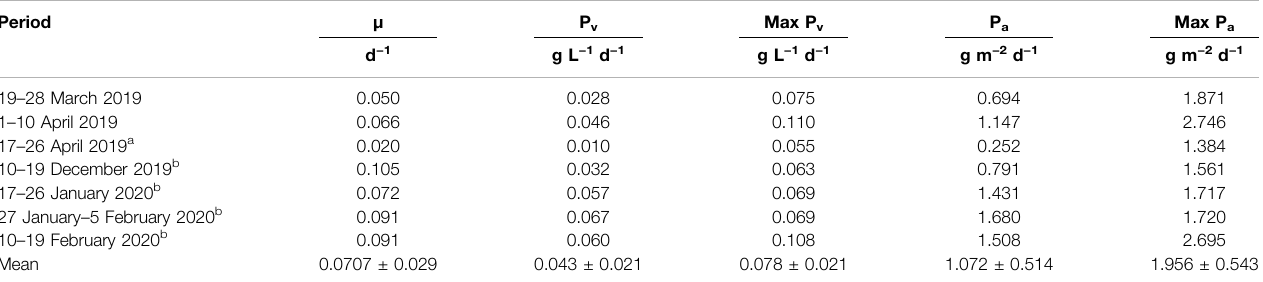
TABLE 1 | Volumetric and areal biomass productivities in dry weight of C. typhlos grown in batch for 9-day periods in a 350-L horizontal tubular reactor and the speci fi c growthratesareshown.Thespeci fi cgrowthrate(µ)iscalculatedoverthe9-dayperiod.Thetotalvolumetric(P v )andareal(P a )productivitiesarecalculatedoverthe9-day periodbydividingthetotaldryweightproducedby9.Themaximumvolumetric(MaxP v )orareal(MaxP a )productivityisthemaximumvalueobtainedforthedailyproductivity during that 9-day